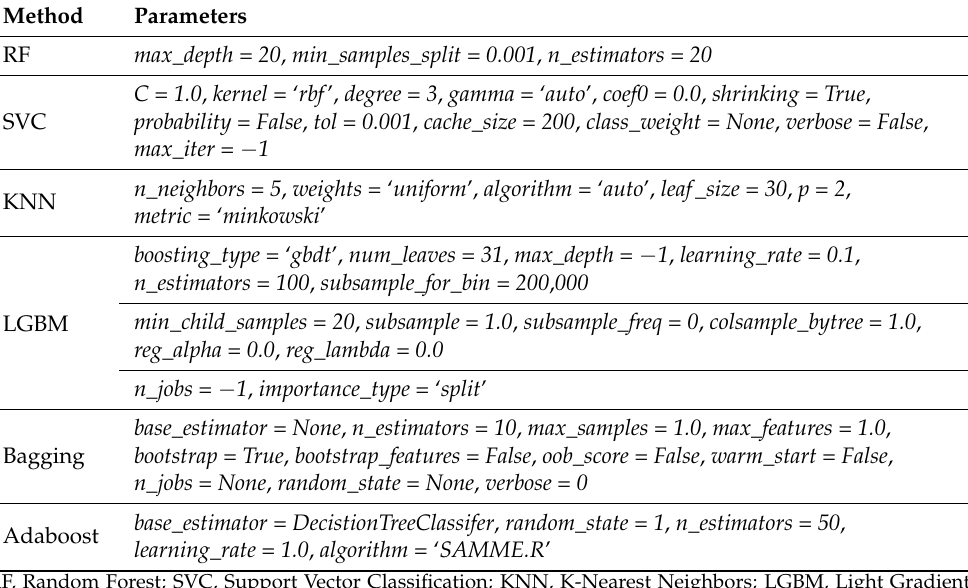
Table 1. The parameters of the six candidate